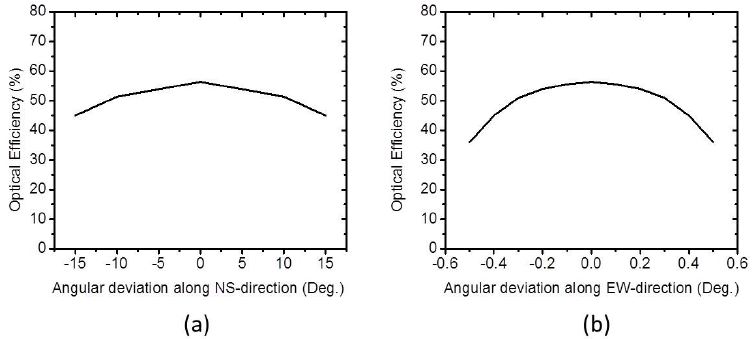
Figure 8. Variation of optical efficiency of concentrator at different angular deviations along the ( a ) NS ‐ direction and ( b ) EW ‐ direction. ( a ) NS-direction and ( b )